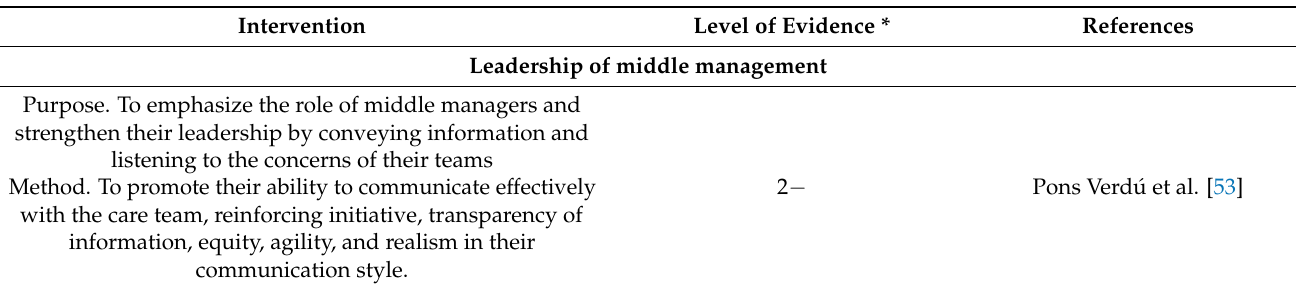
Table 5. Interventions to strengthen the role of middle